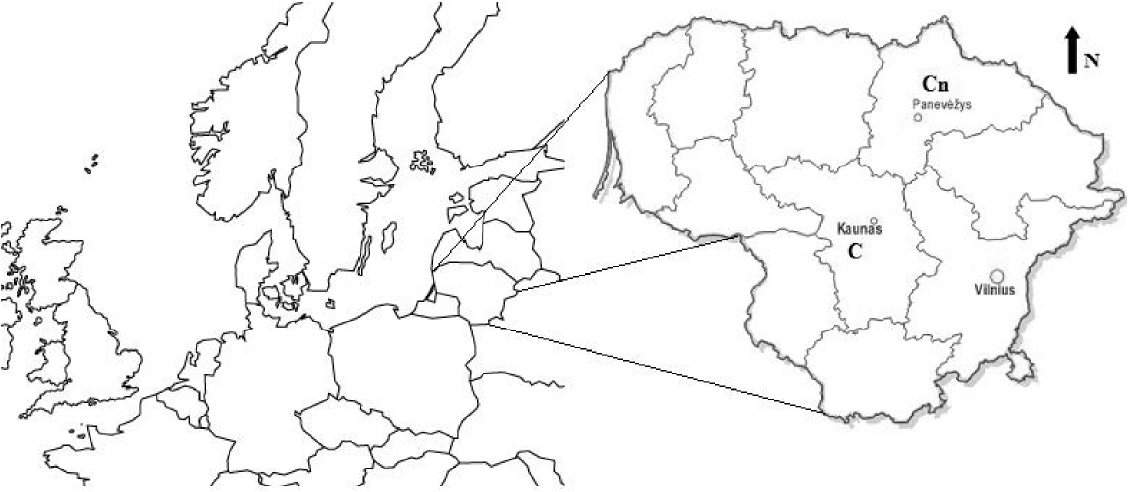
Fig. 1. Location of the sampling plots in Lithuania (Cn – contamined sampling plot, C – control sampling